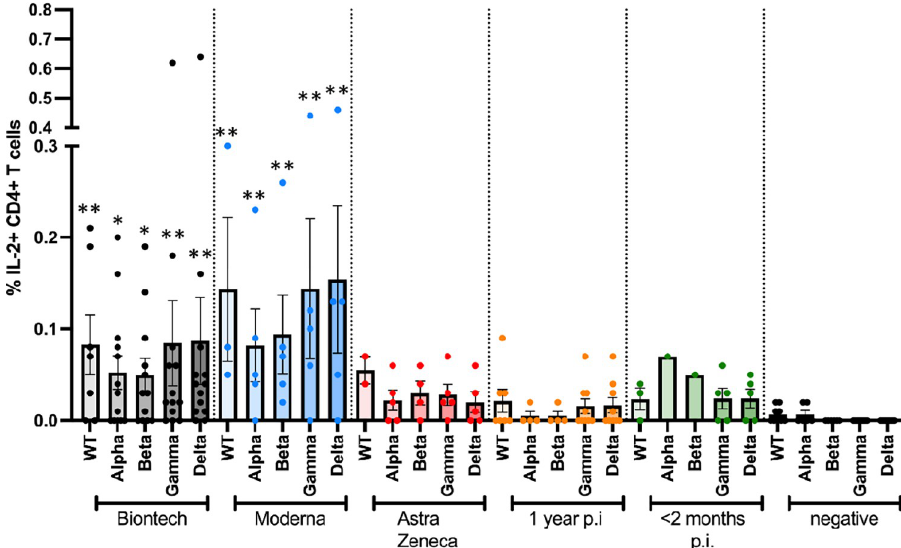
Fig 5. Antigen-specific IL2+ CD4+ T cell responses to JPT peptide S protein wt and mutant pools. Antigen-specific CD4+ T cell responses elicited by the JPT peptide S protein pools after vaccination with BioNtech (grey), Moderna (blue) or AstraZeneca (red), or one year (orange) or < 2 months (dark green) after naturally occurring infection with SARS-CoV2, or negative controls. The bar graphs show frequencies of interleukin-2 (IL-2)-positive CD4+ T cells for wild type, and for alpha (B.1.1.7), beta (B.1.351), gamma (P.1) and delta (B.1.617.2) mutants. The figure shows results of n = 13 independent individuals after vaccination with BioNtech, n = 5 Moderna, n = 5 AstraZeneca, and n = 10 independent individuals one year and n = 7 < 2 months after natural infection with standard errors of the mean (SEM). Samples of non infected individuals tested negative (not shown in the figure to enhance legibility). Significance levels were tested by Kruskal-Wallis test for non-parametric values. �� p < 0.01 vs. healthy controls, and p < 0.05 vs. 1 year after